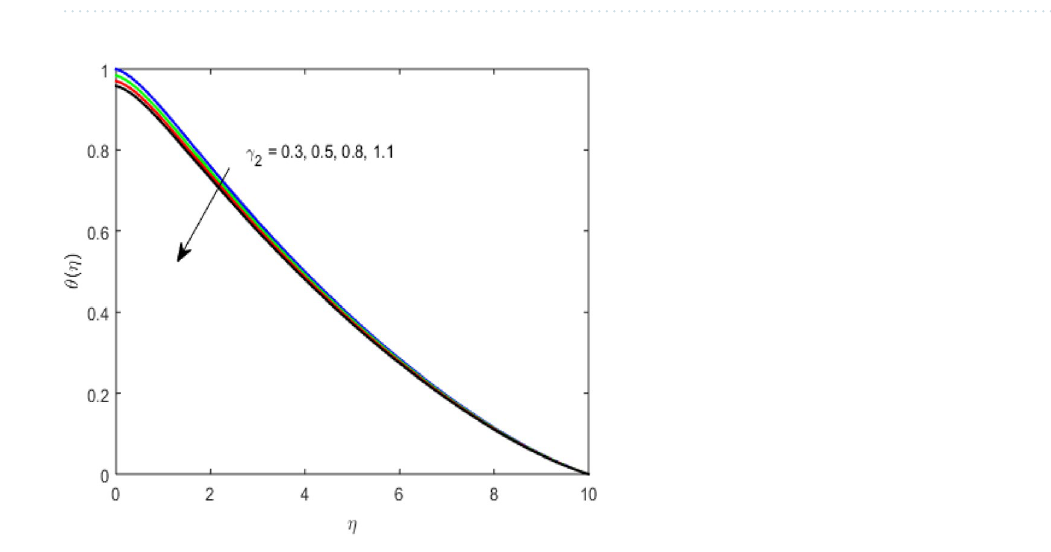
Figure 11. ( Re r ) − 1 / 2 Nu versus γ 2 for varying N t .